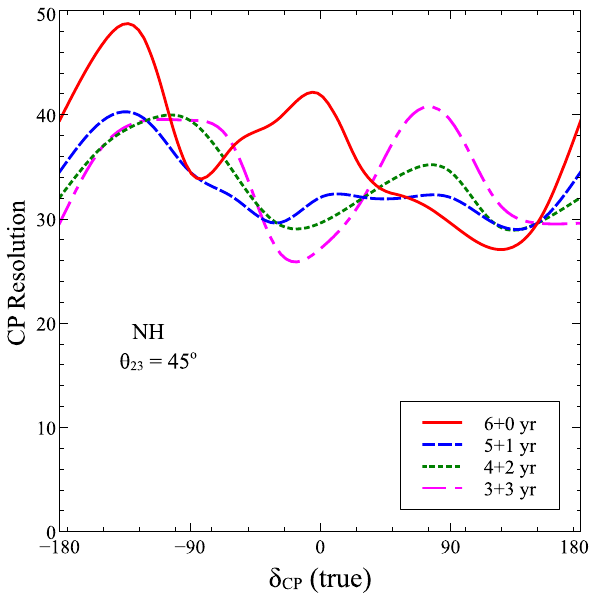
Fig. 9 CP resolution sensitivity in NH. This is shown for θ 23 (true) = 45 ◦ and taking four different combinations of neutrino–antineutrino